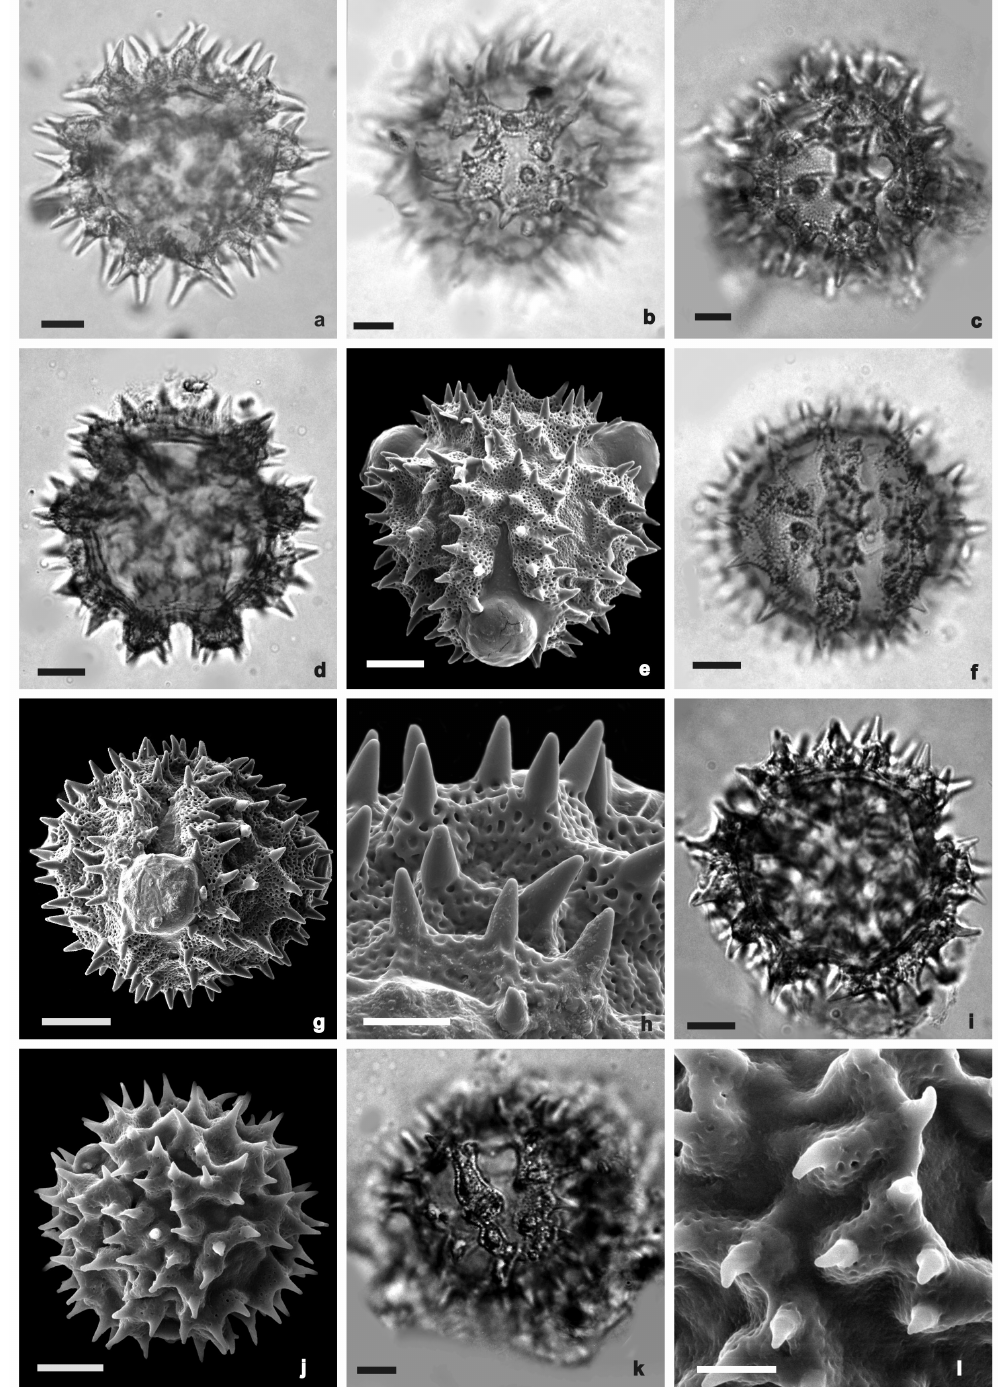
Figure 1. Light microscopy (LM) and scanning electron microscopy (SEM) images of pollen grains of Piptolepis species. P. buxoides - a. polar view, optical section (ML), b. surface (ML), c. equatorial view, general aspect and aperture (ML). P. campestris - d. polar view, optical section (ML), e. general aspect (SEM), f, g. equatorial view, general aspect and aperture (ML and SEM), h. surface detail (SEM). P. ericoides - i. polar view, optical section (ML), j. general aspect (SEM), k. equatorial view, aperture (ML), l. surface detail (SEM). Scale bar: 10 µm (a-g, i-k), 1 µm (h,